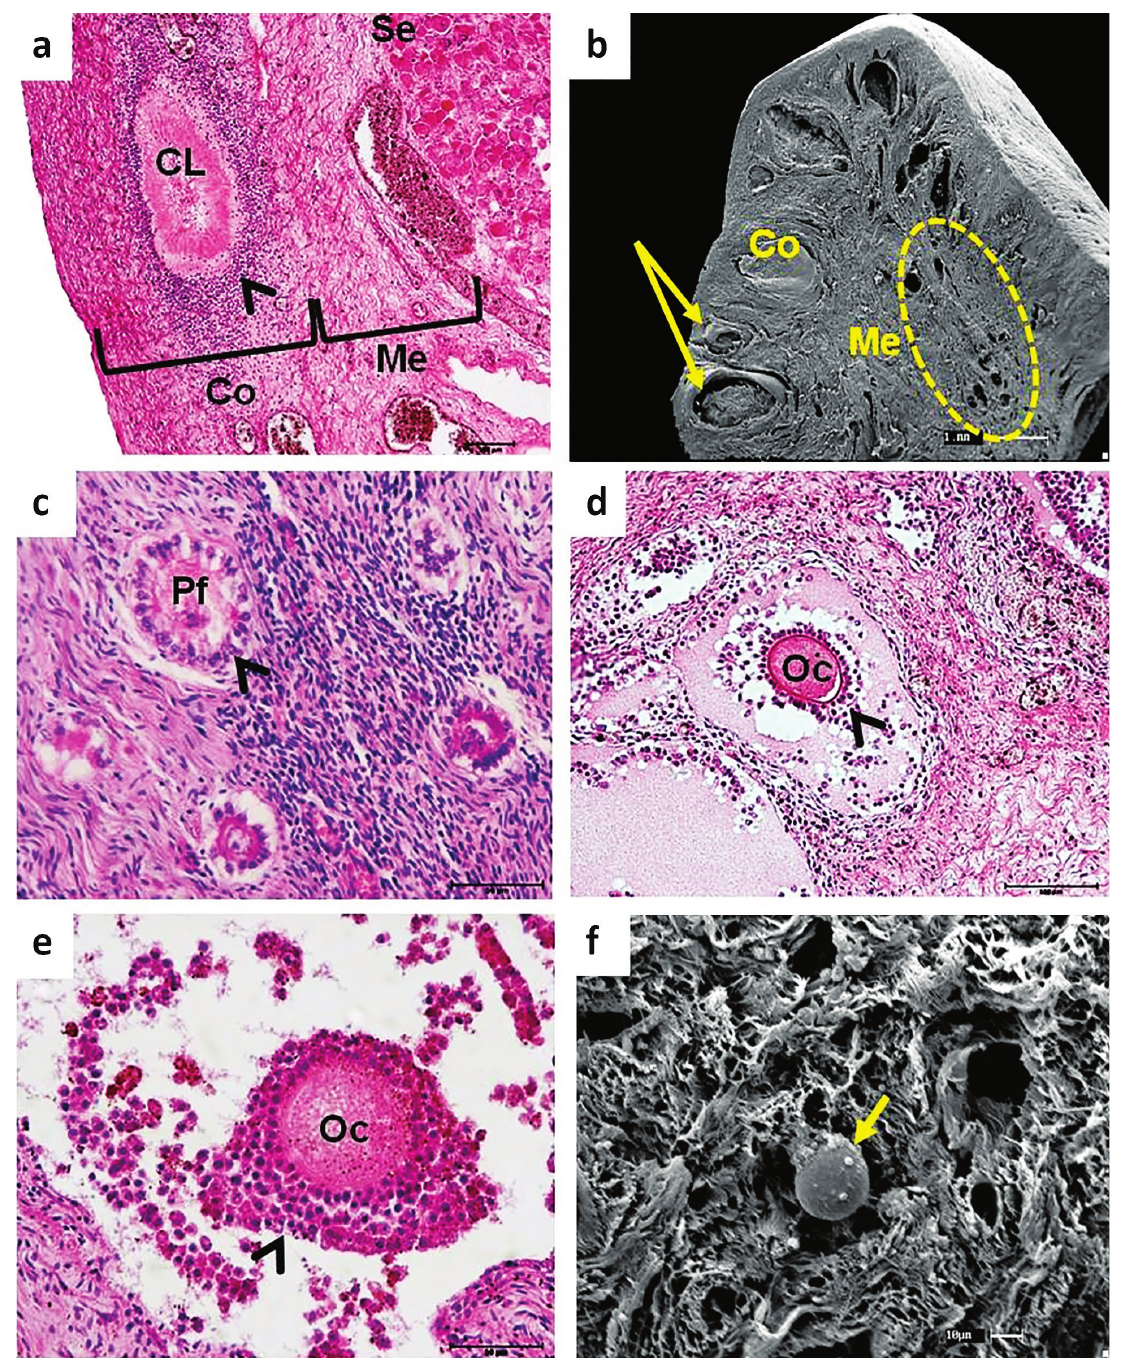
Figure 3 - Photomicrograph of the ovary from Sotalia guianensis . a. Cortical region (Co) with the presence of corpus luteum (CL) in regression. Connective tissue (arrowhead) entering the luteal cells. Medullary region (Me). 10x. Hematoxylin-eosin (HE). b. Ovarian follicles (arrows) in different degrees of development in the cortical region (Co). Presence of blood vessels (highlighted) in the medulla. (Me). 40x. HE. c. Primary follicle (Pf) surrounded by a single layer of follicle cells (arrowhead). 40x. HE. d. Oocyte (Oc) with zona pellucida (arrowhead). 20x. HE. e. Oocyte (Oc) and granulosa cells (arrowhead). 40x. HE. f. Scanning electron photomicrograph. Oocyte (arrow) with few granulosa cells adhered to its